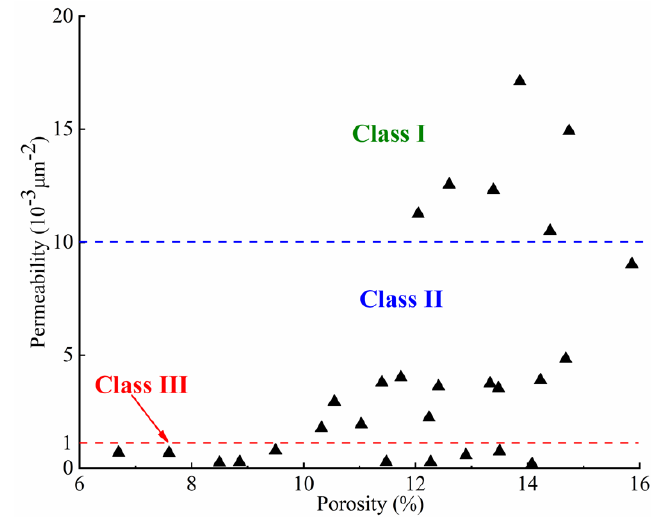
Figure 1. Distribution diagram of reservoir permeability and porosity in Wen 23 gas field.